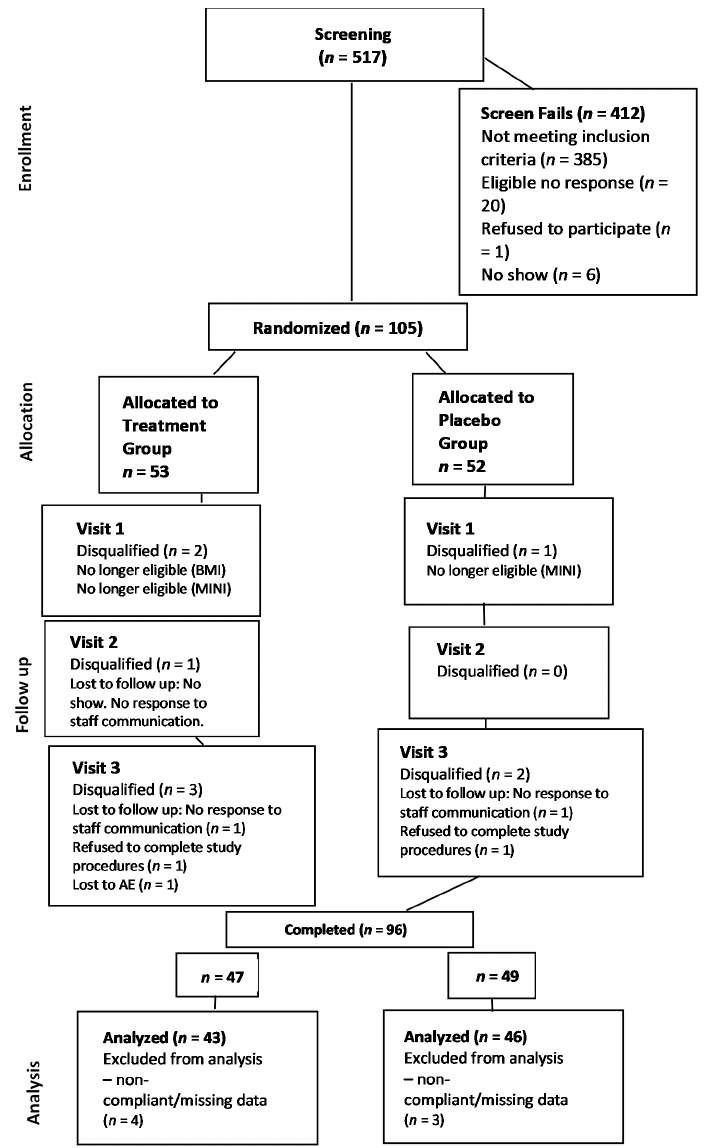
Figure 1. CONSORT flow diagram of study recruitment, randomization, and activities.